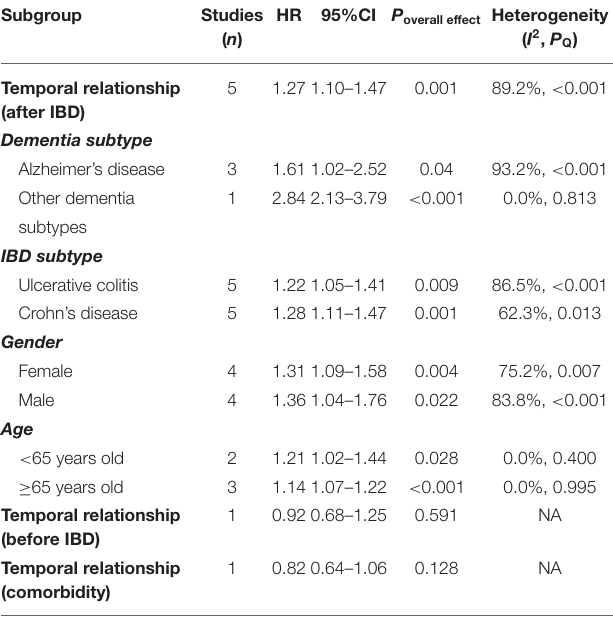
TABLE 2 | Results of meta-analysis of the association between IBD and